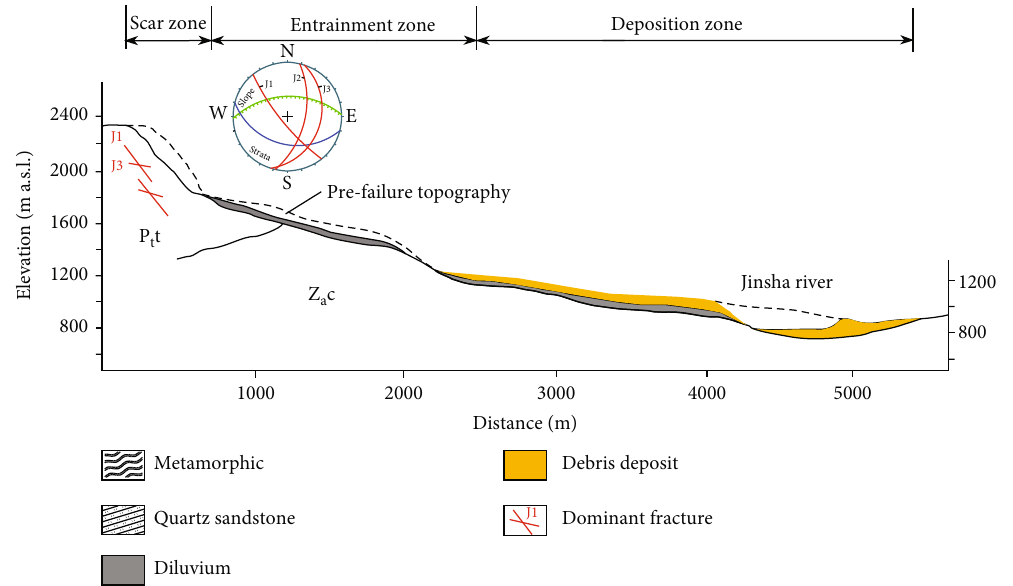
Figure 3: The longitudinal section of